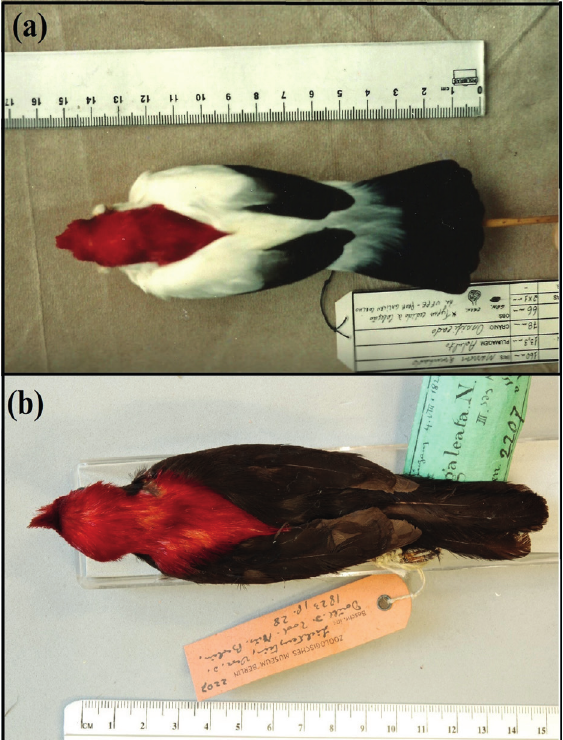
Figure 1 - Dorsal view of the holotypes of ( a ) Antilophia bokermanni (No. 1130 – Ornithological Collection of the Universidade Federal do Pernambuco, Recife) and ( b ) Antilophia galeata (ZMB#2207 – Ornithological Collection of the Zoologisches Museum, Berlin).